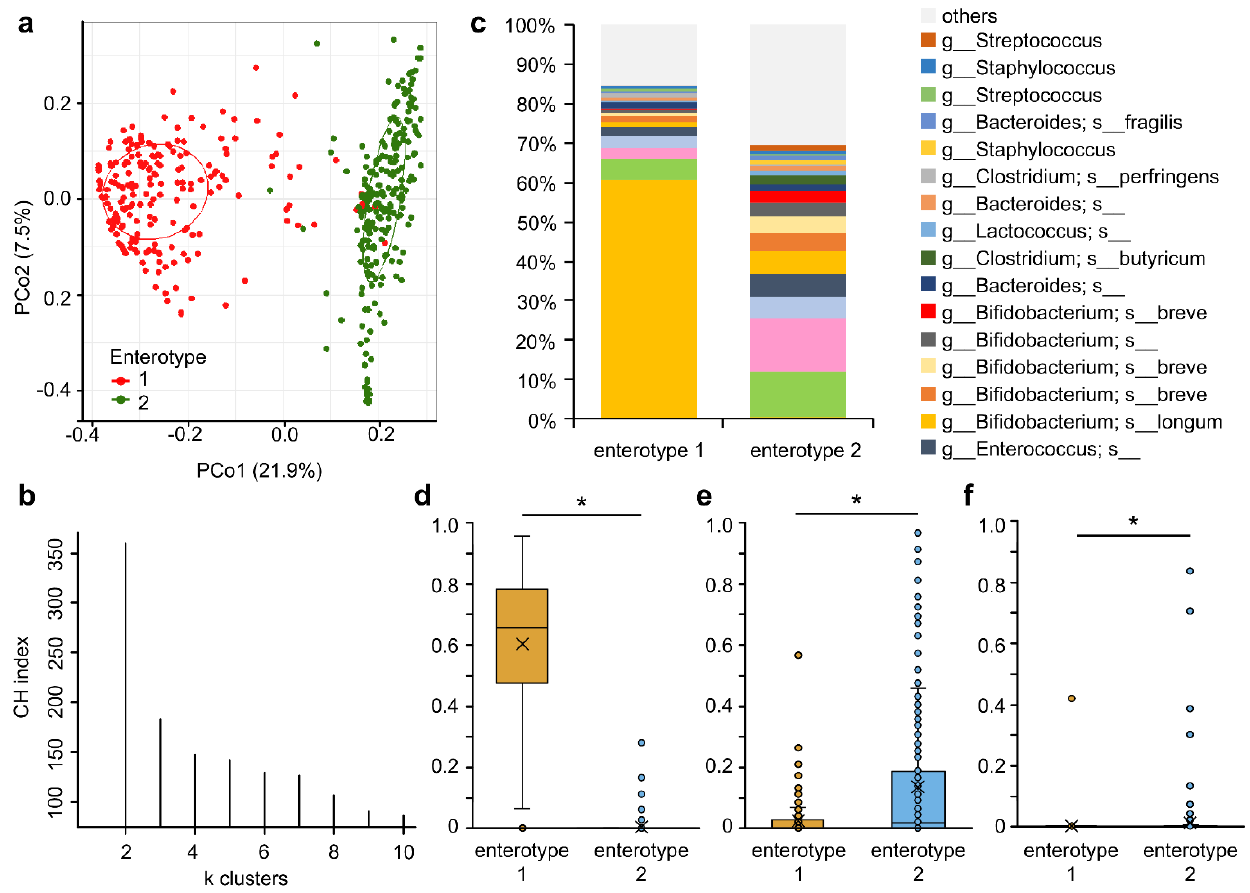
Figure 2. Enterotype of subjects during the intervention. ( a ) Principal coordinate analysis (PCoA) as seen through the first two principal coordinates (PCo1 and PCo2) based on Jensen–Shannon distance (JSD) calculated by the fecal microbiota composition at the ASV level; ( b ) PAMs clustering with JSD. The estimated suitability of the cluster number Calinski–Harabasz index; ( c ) top 20 ASVs in the fecal microbiota composition in each enterotype; ( d ) relative abundance of ASVs annotated as the B. longum group, including B. longum subsp. infantis and B. longum subsp. longum ; ( e ) the relative abundance of ASVs annotated as Enterobacteriaceae ; ( f ) the relative abundance of ASV annotated as Lactococcus . Asterisks (*) indicate q < 0.05 calculated by ALDEx2.